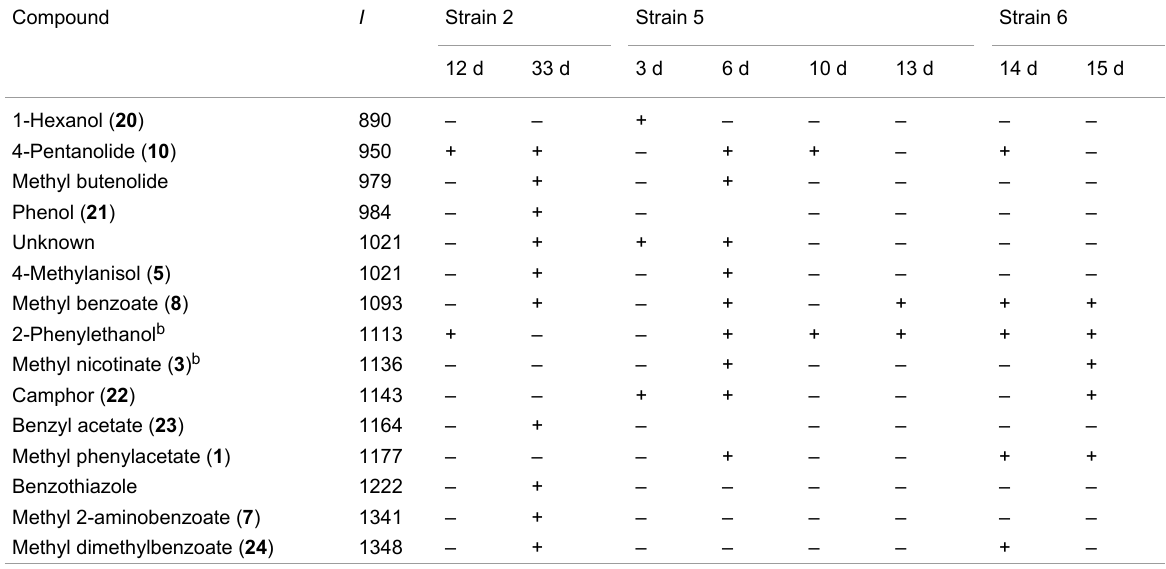
Table 4: Volatiles released by Mycobacterium tuberculosis grown in a 7H9 broth medium. a